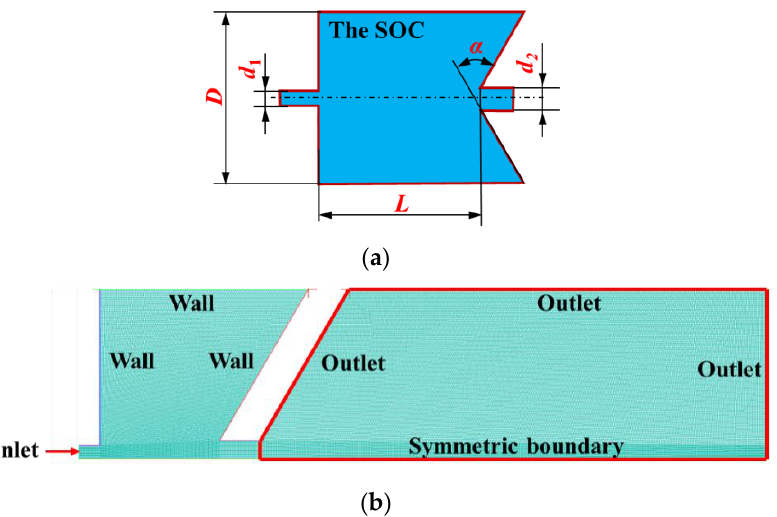
Figure 2b. The fluid domain is made up of 225,097 cells. A domain mesh refinement scheme is 0.2 mm. is used in the central region of the calculation model and the minimum size is 0.2 mm.